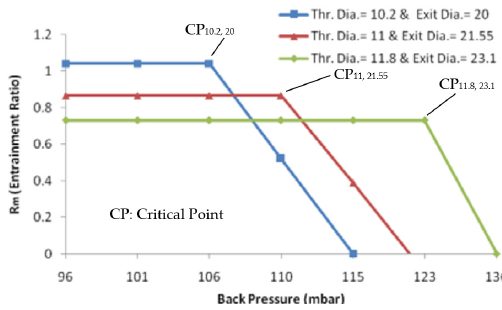
Figure 6. Entrainment ratio vs. back pressure for the ejector (source [55]).